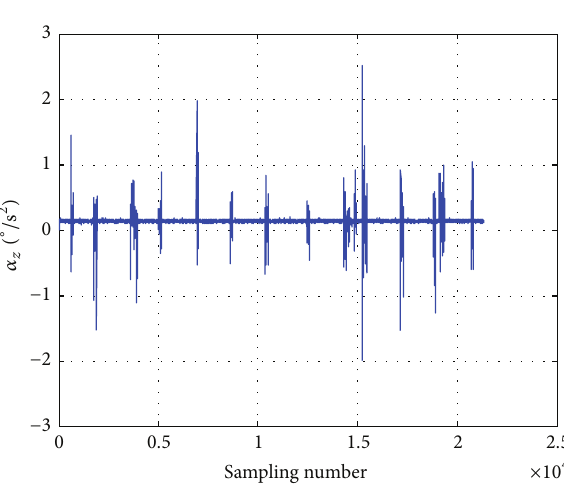
Figure 20: Measured sound power levels for controlled and uncon- trolled suspension